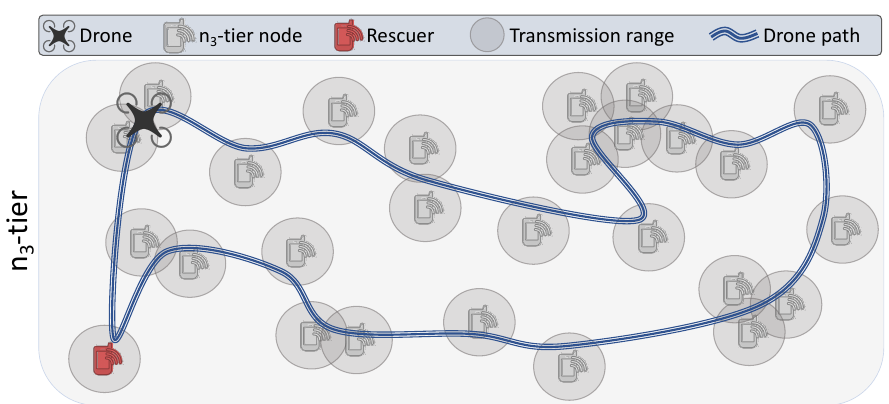
Figure 7. Shortest path for a drone to visit all the anchor